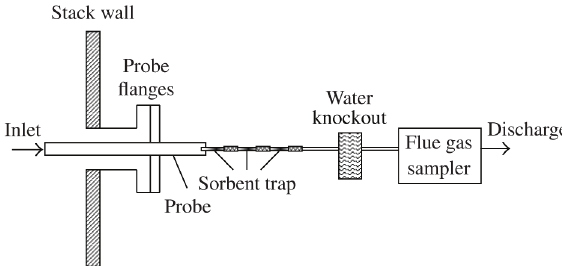
FIGURE 5: Sampling train in